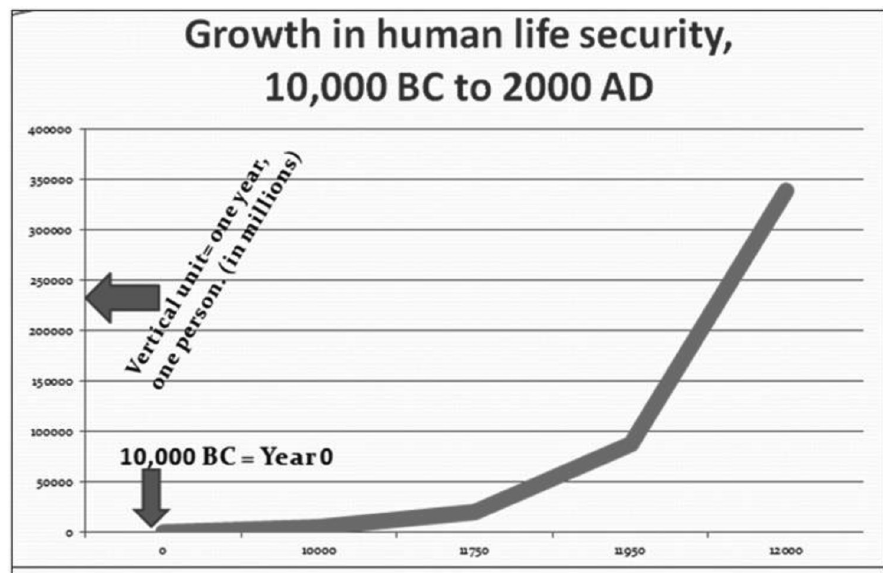
Figure 1: Historical growth of life